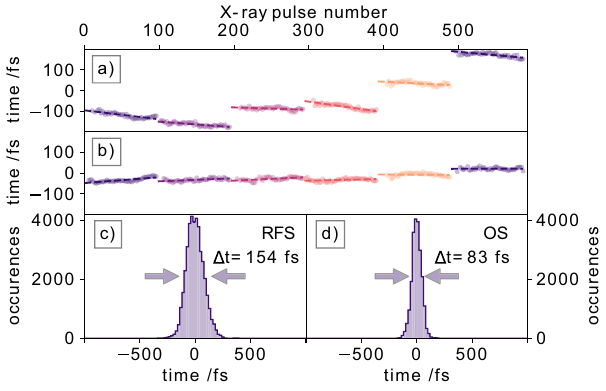
Fig. 5 | Analysis of measured X-ray arrival times. Relative arrival times for 6 consecutive pulse trains, with each 100 X-ray pulses, are shown, ( a ) via radio- frequency synchronisation (RFS) of the electron bunches, ( b ) via the optical syn- chronisation(OS)scheme.Foreachpulsetrain,alinearfunctionis fi ttedtoindicate the common drift patterns of the relative arrival times within a pulse train. The timing jitter distribution over a time span of 100 s is shown in ( c ) for the RFS ( Δ t =154±19 fs) and ( d ) for the OS ( Δ t =83±19fs) schemes.